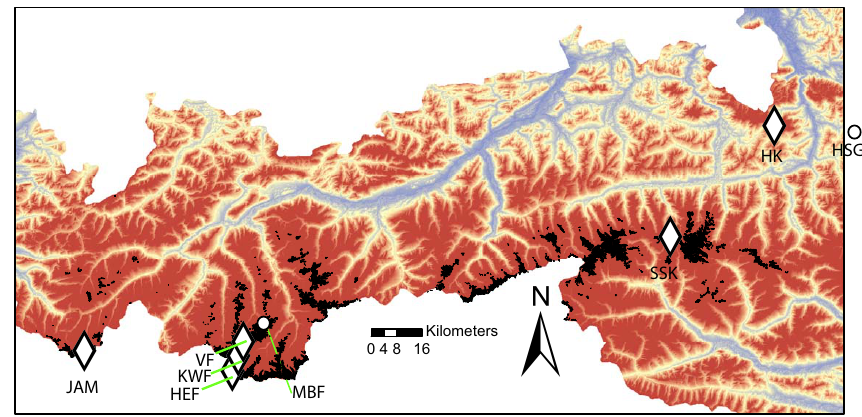
Fig. 3. Location of the Austrian test glaciers JAM,HEF, KWF, VF, SSK and HK (rhombs) and Mittelbergferner/MBF and Hallst¨atter Glacier/HSG (dots). DEM data from Jarvis et al. (2008).